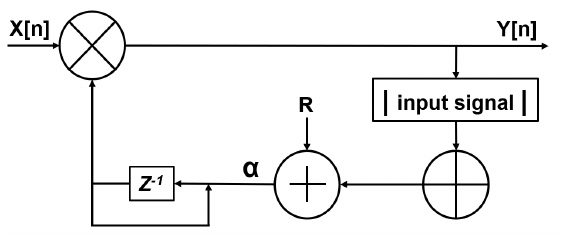
Figure 9. Schematic of the proposed digital